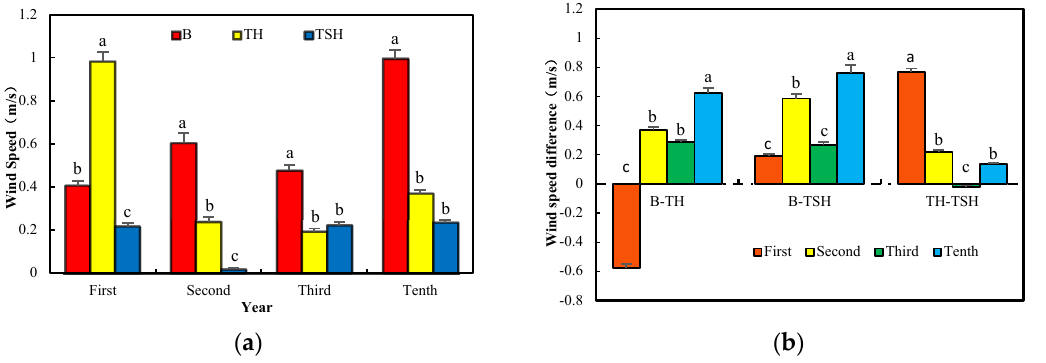
Figure 8. ( a ) Average wind speeds of different vegetation type combinations in different restoration years; ( b ) Wind speed differences of different vegetation type combinations in different restoration years. (a–c): the different letters indicate that there is a significant difference between two vegetation type combinations ( p < 0.05).